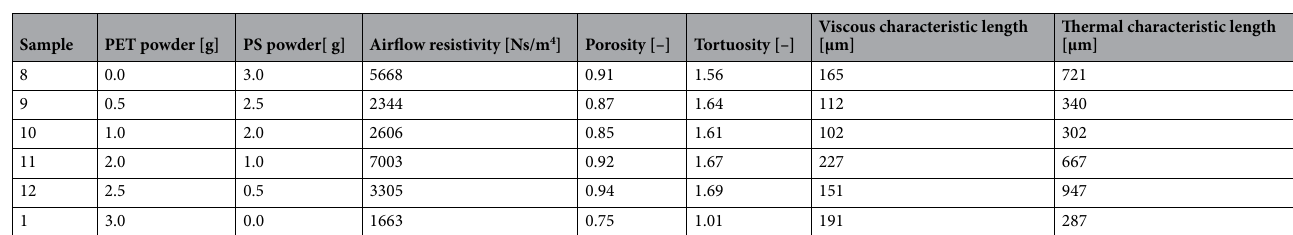
Table 8. Microplastics powder ratio variation affects JCA model